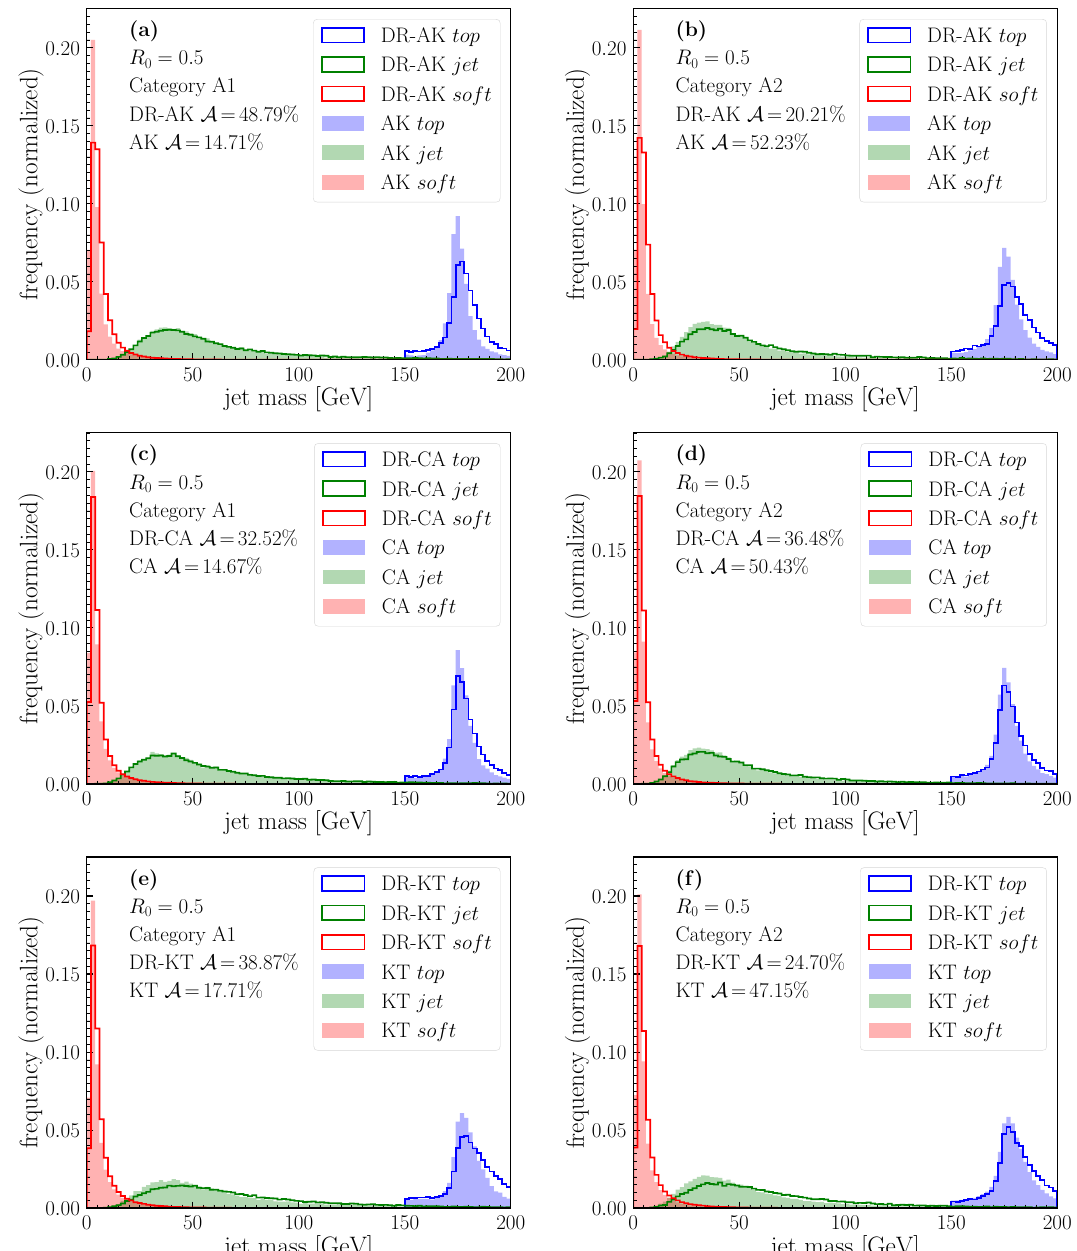
Figure 4 . Normalized distribution of jet mass for the process pp → tj . The left panel shows the distribution for category A1 events while the right panel is the distribution for category A2 events. The blue, green, and red histograms are for reconstructed top , hard jet , and soft jets (defined in the text), respectively. The histograms, from top to bottom, are for AK, CA, and KT algorithms. The filled histograms correspond to fixed radius algorithms and the unfilled ones correspond to their dynamic radius (DR)